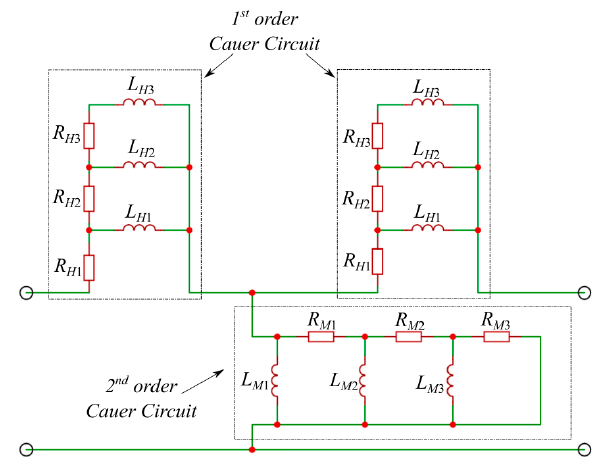
Figure 4. The proposed equivalent circuit for the transformer of the WPTS.